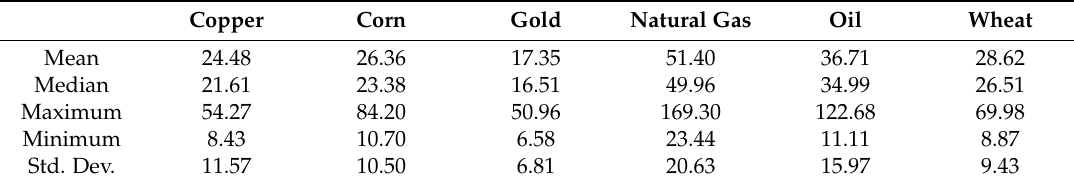
Table 2. Summary Statistics—Realized Volatility.